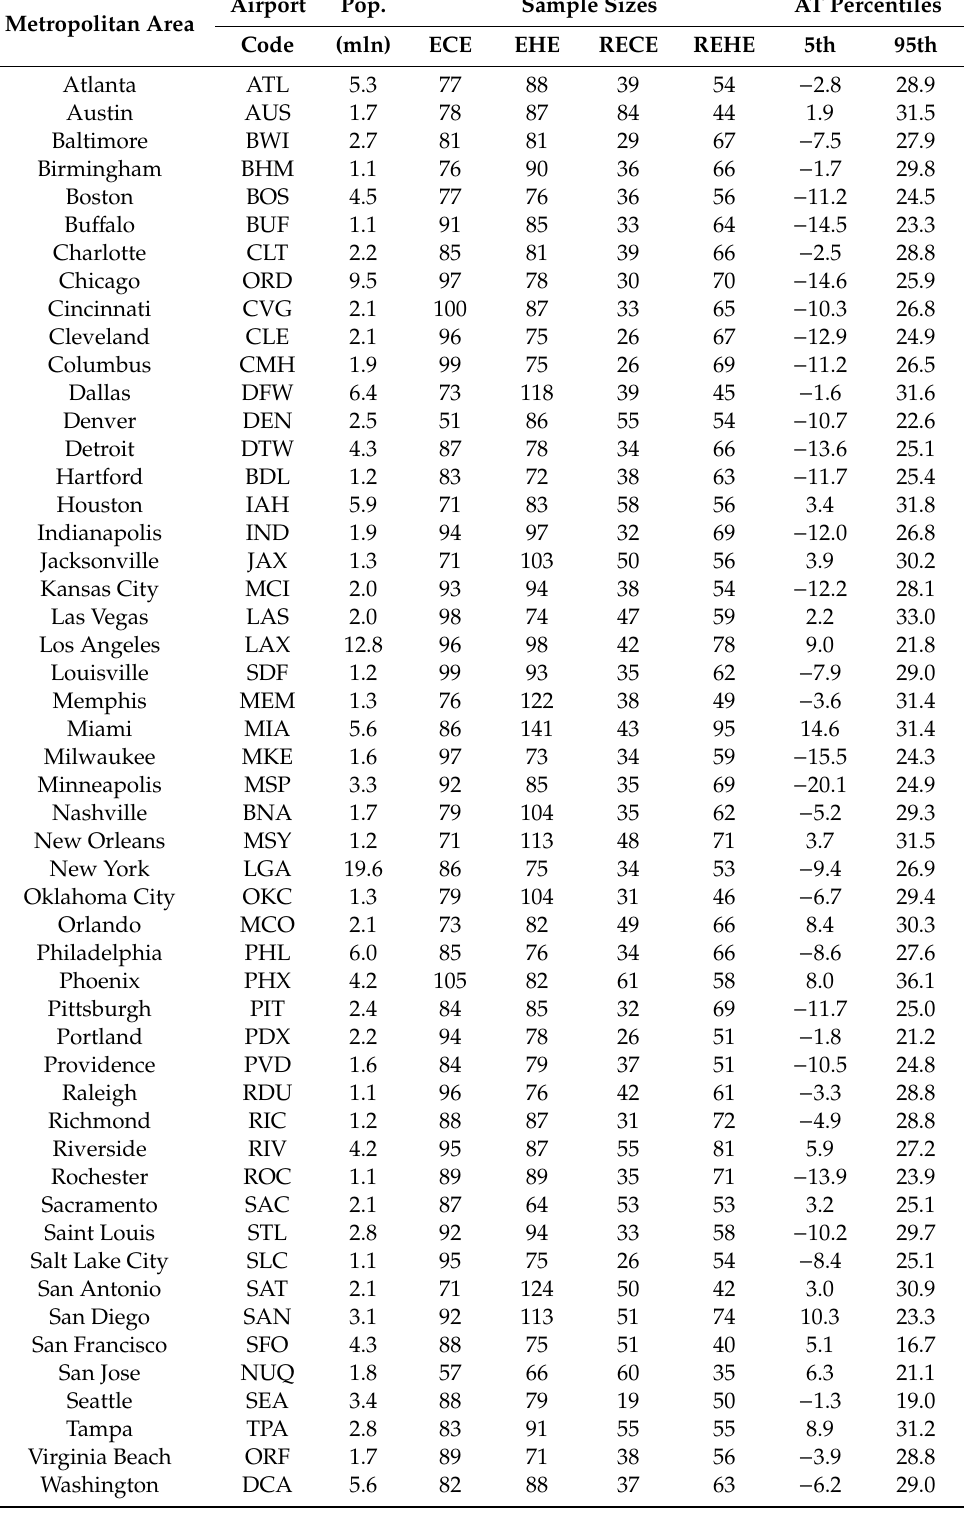
Table 1. The 51 metropolitan areas used in this research, their 2010 populations, sample sizes of ETE event days, and apparent temperature percentiles ( ◦